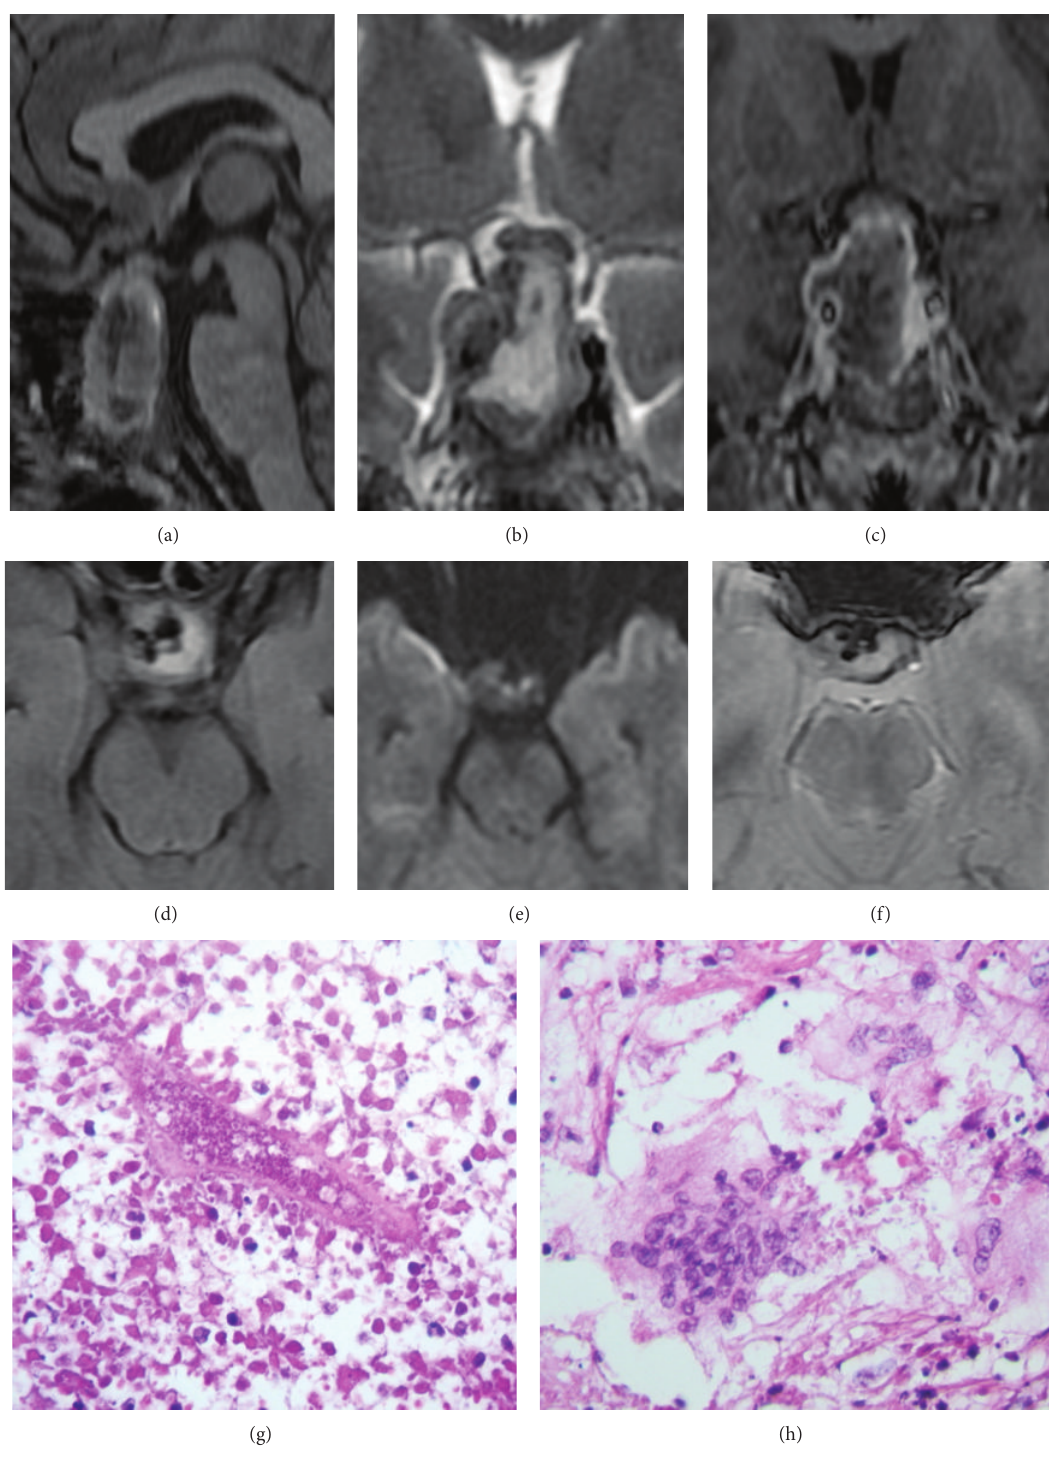
Figure 2: (a) MRI sagittal T1-weighted, (b) coronal T2-weighted images, (c) coronal T1-weighted images after contrast media administration, (d)axialT2-FLAIR-weightedimages,(e)axialdiffusionweightedimages,and(f)T2 ∗ -weightedimagesofa50-year-oldwomanwithheadache associated with raised pressure and vertical diplopia revealed a sellar and suprasellar lesion with hemorrhagic areas displacing dorsally the chiasm,thickeningtheinfundibulumandcavernoussinusextensionpredominantlytotherightside.(g)Photomicrograph × 100H&Eand(h) photomicrograph × 400 H & E showed pituitary parenchymal necrosis with blood vessel and group of multinucleated giant cells surrounded by lymphocytes and epithelioid